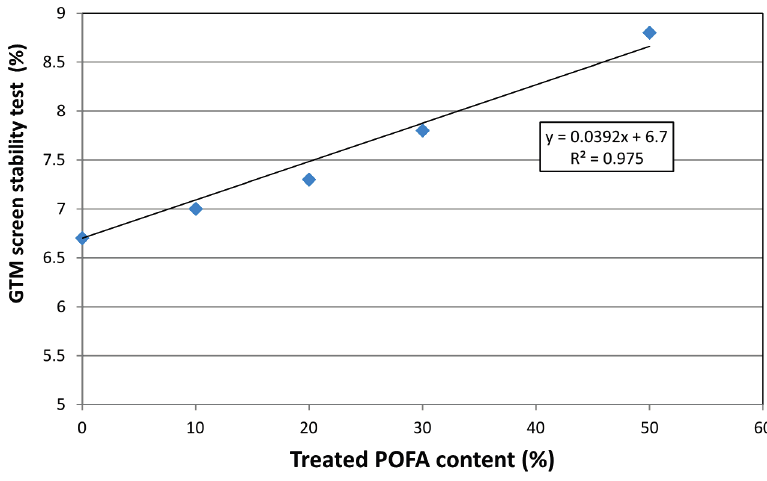
Figure 9. Segregation resistance for SCC with treated